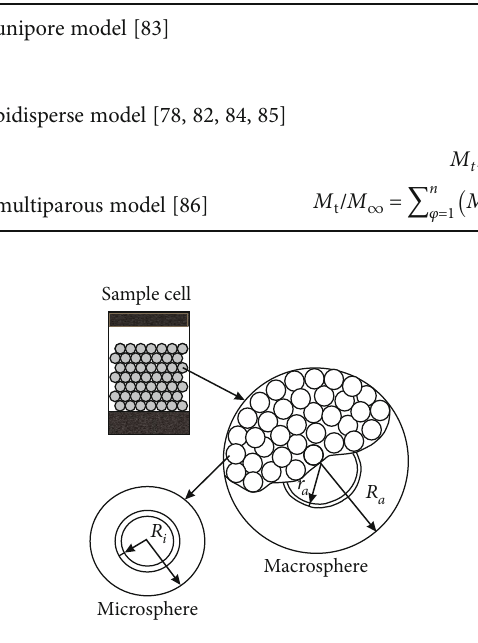
Figure 12: Conceptual model of the bidisperse pore structure in coal reservoirs (modi fi ed from Clarkson and Bustin